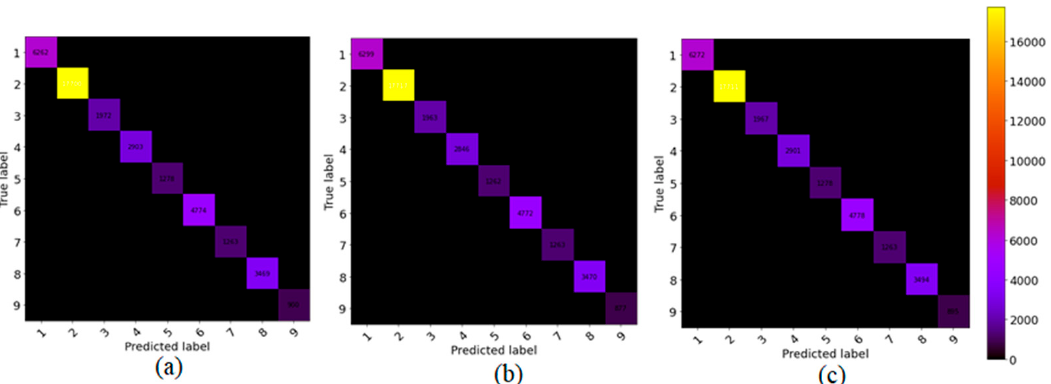
Figure 6. The confusion matrix for classification results of ( a ) SSRN, ( b ) HybridSN ( c ) GGBN over